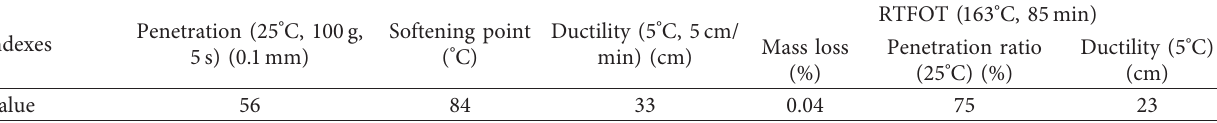
Table 1: Basic properties of SBS-modified asphalt.